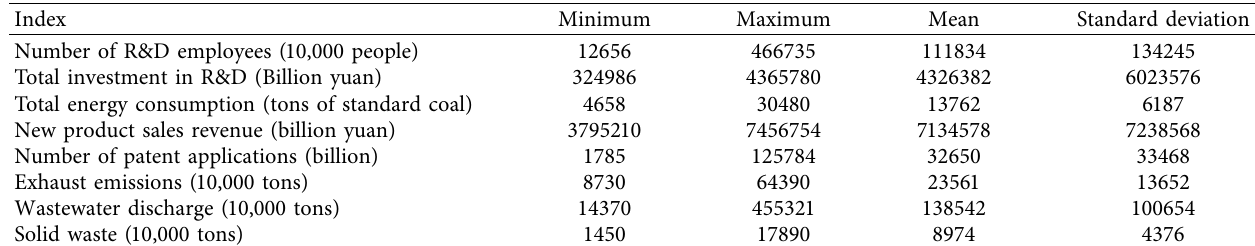
Table 3: Descriptive statistics of green innovation efficiency in YREB.